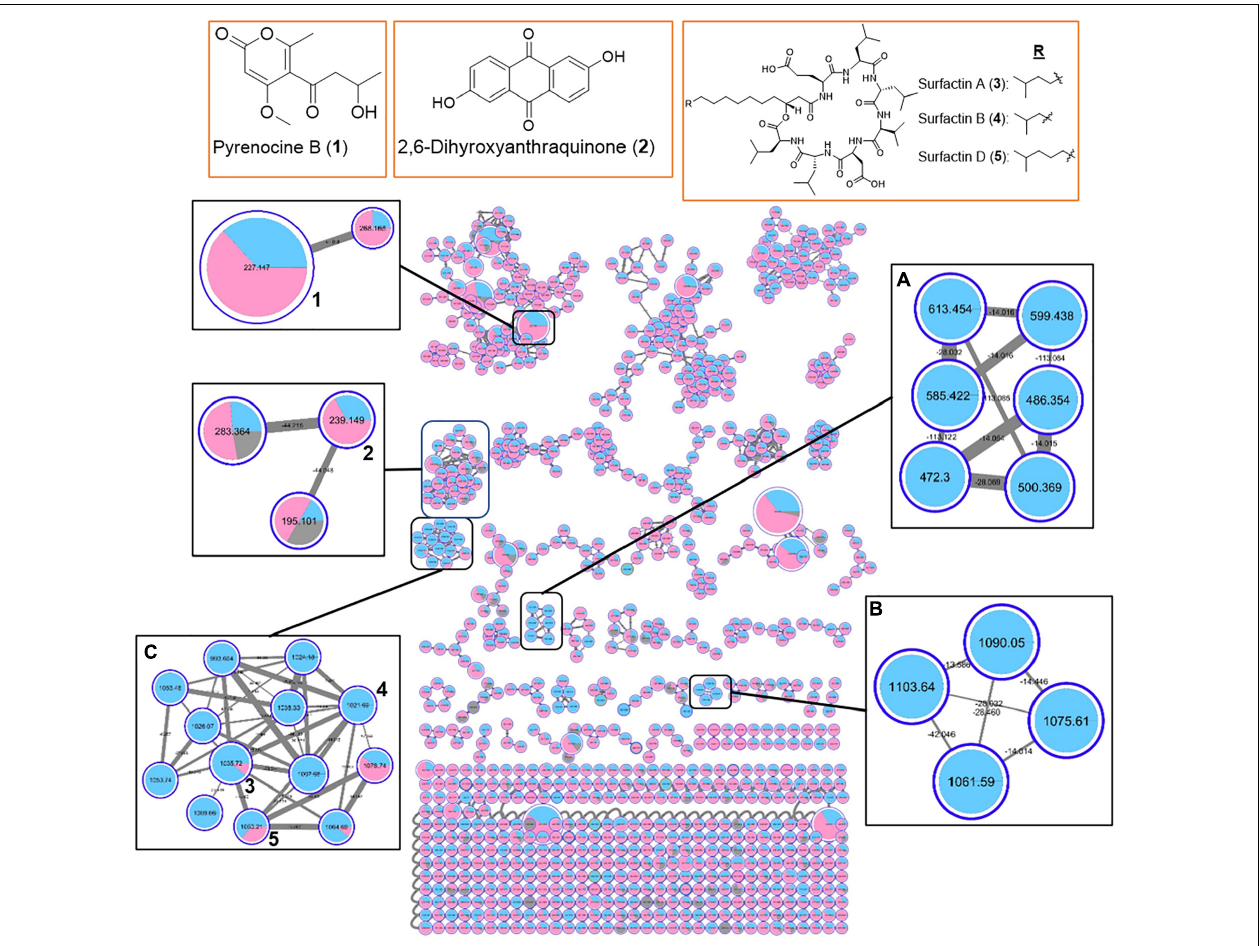
FIGURE 6 | Molecular network of 973 parent ions detected in 11 marine bacterial strains belonging to class Bacilli (phylum Firmicutes ) (Blue) and class Alphaproteobacteria (phylum Proteobacteria ) (Pink). Nodes due to MeOH blank are in gray. Within each box, the different nodes represent the different ions detected in the bacterial extracts while the node sizes represent the relative abundance of the different parent ions. Within each node, the relative abundance of a particular ion detected in the different bacterial strains is depicted by the sizes of the colored wedge. The edge thickness reflects the similarity between each parent ions with thicker edge showing higher similarity. Nodes with associated numbers 1 to 3 correspond to the detected compounds and their chemical structures are shown in the top row of